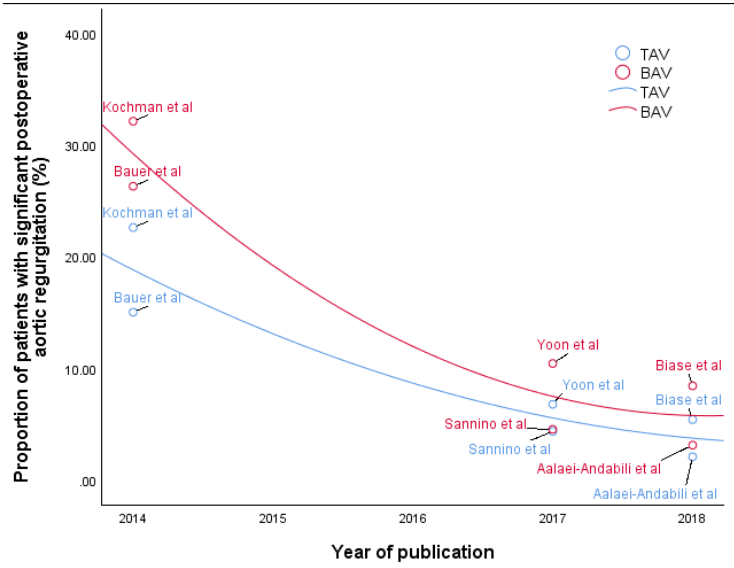
Fig. 11 - Rate of significant postoperative aortic regurgitation in studies according to the year of publication. A decreasing trend is apparent. BAV=bicuspid aortic valve; TAV=tricuspid aortic valve